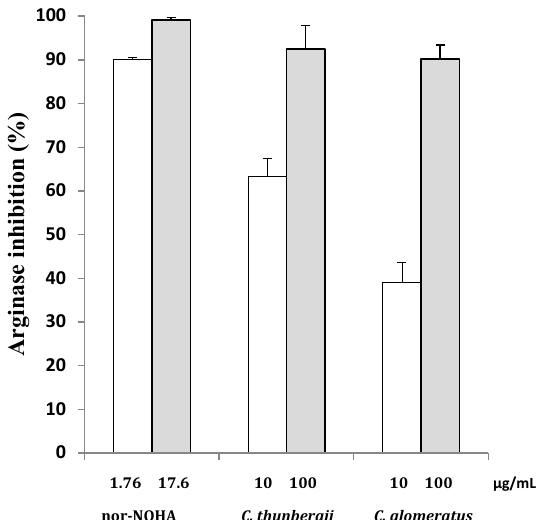
Figure 1. Arginase inhibition (at 10 and 100 µ g/mL) of the methanolic extracts of Cyperus thunbergii , Cyperus glomeratus, and N ω -hydroxy-nor-l-arginine (nor-NOHA) (positive control at 10 and 100 μ M corresponding to 1.76 and 17.6 µg/mL, respectively). Results are expressed as means ± standard deviation (SD) obtained from three distinct experiments performed in duplicate.